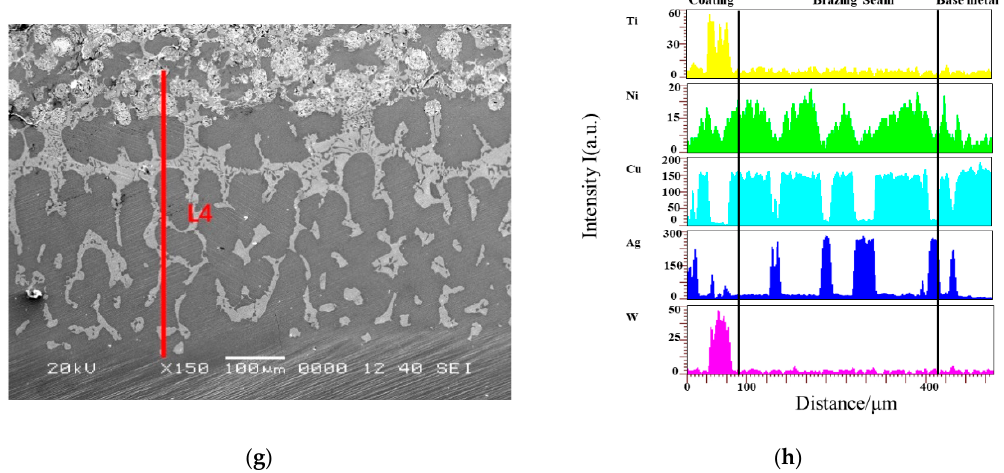
Figure 7. Element distribution a brazed interfaces ( a ) Line scanning position of the 830 °C coating; ( b ) Element distribution of the 830 °C coating; ( c ) Line scanning position of the 860 °C coating; ( d ) Element distribution of the 860 °C coating; ( c ) Brazing seam interior; ( e ) Line scanning position of the 890 °C coating; ( f ) Element distribution of the 890 °C coating; ( g ) Line scanning position of the 920 °C coating; ( h ) Element distribution of the 920 °C coating.